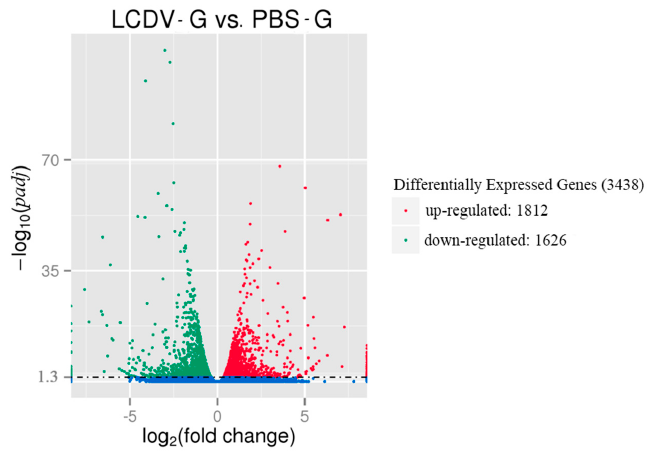
Figure 5. The ‘‘volcano plot’’ picture of DEGs between LCDV-infected and control groups. Red spots and green spots represented significantly up-regulated and down-regulated genes, respectively ( padj < 0.05 and |log 2 (fold change)| > 1). Blue spots: no difference in gene expression.